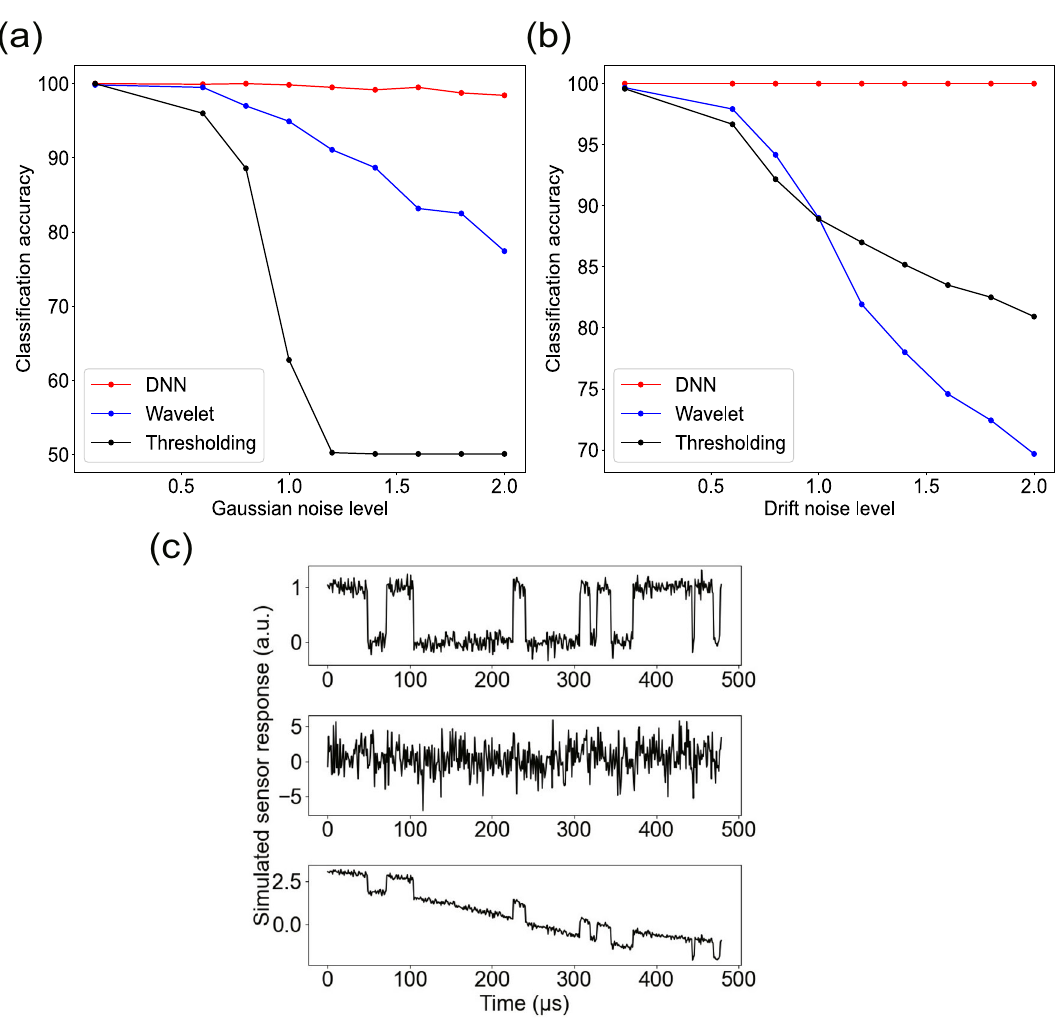
Fig. 2 Comparisons of classi fi cation accuracies. Comparisons of classi fi cation accuracies among the DNN classi fi cation, the wavelet method, and thresholding as a function of ( a ) Gaussian noise level and ( b ) drift noise level added to the arti fi cial charge transition signals that are generated by the Markov chain model. ( c ) Simulated real-time sensor response including charge transition signals with Gaussian noise level of 0.1 (top), Gaussian noise level of 2.0 (middle), and drift noise level of 2.0 (also added Gaussian noise level of 0.1 to imitate the sensor response in experiments)